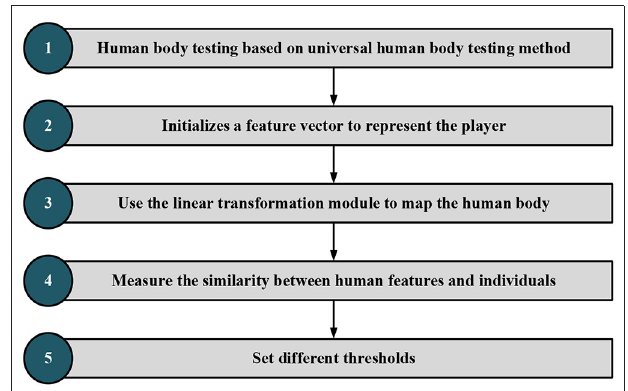
FIGURE 9 | Identification and detection steps.